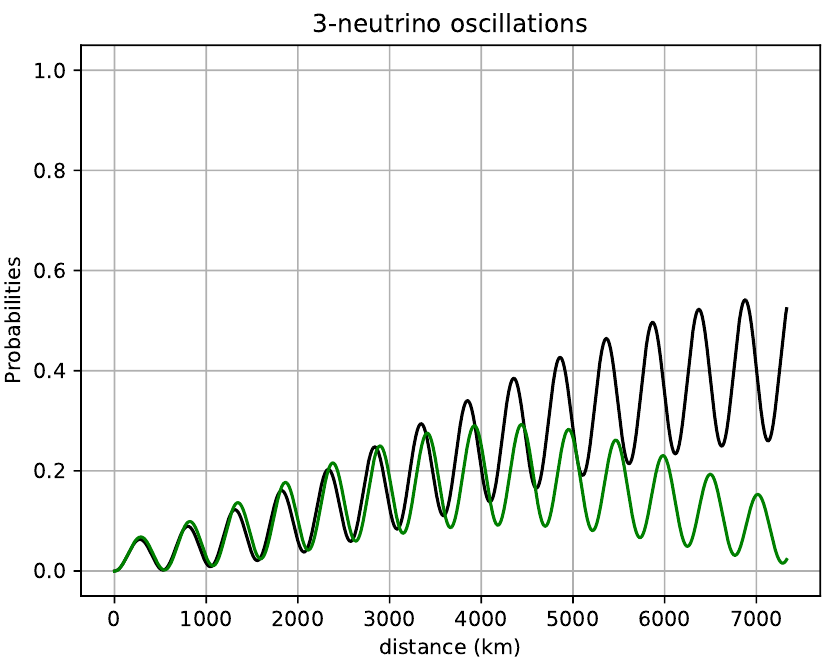
Figure 3. Calculated P ν for a baseline of 7330 km and muon neutrino energy of 0.5 GeV. The green µ → ν e line is given by a constant matter density approach ( ρ = 3.8 g/cm 3 ). The black line was obtained by integrating Equation (8), with a precision of 10 − 10 /step using an equivalent spiked electron density, and it is shown to be incorrect (see text for details), while the green curve is the correct